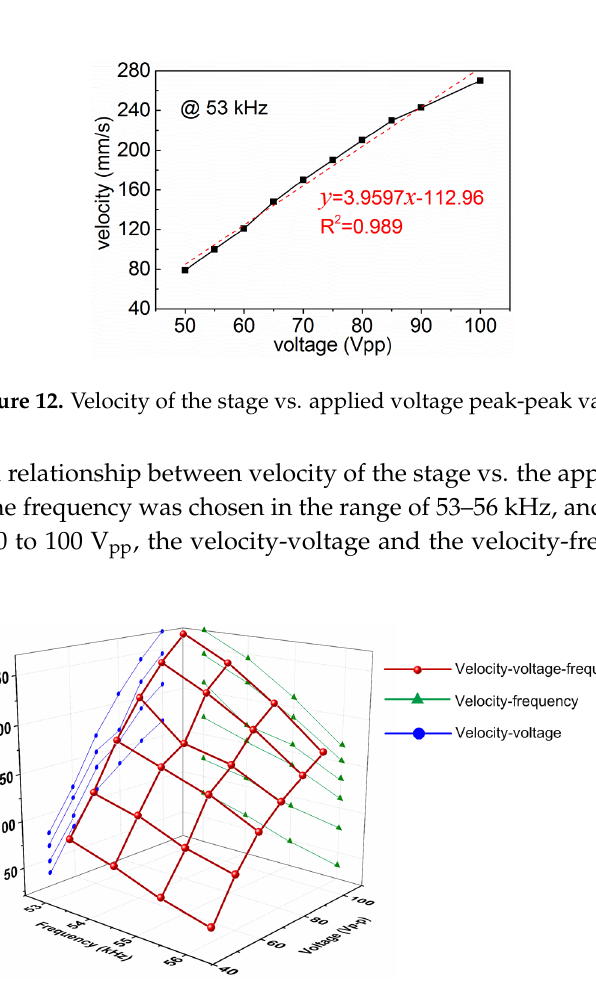
Figure 13. Velocity of the stage vs. applied voltage peak ‐ peak value and frequency.